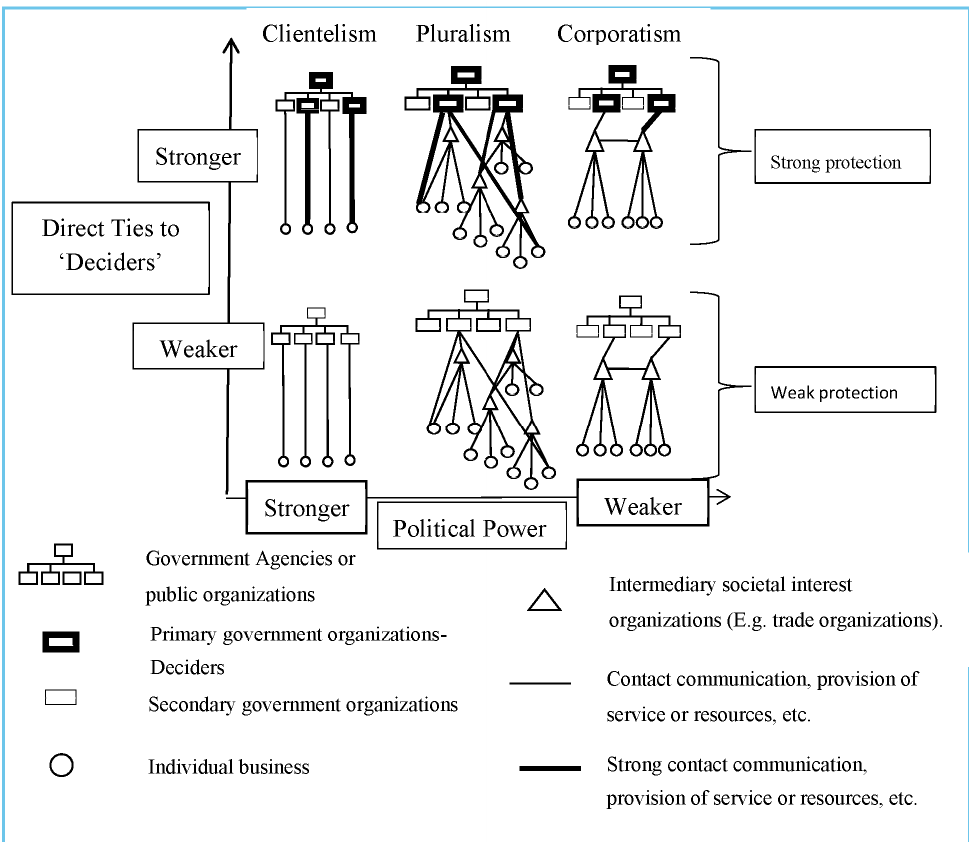
Figure 1. Policy networks structures (framework modified from Schneider (1992)).